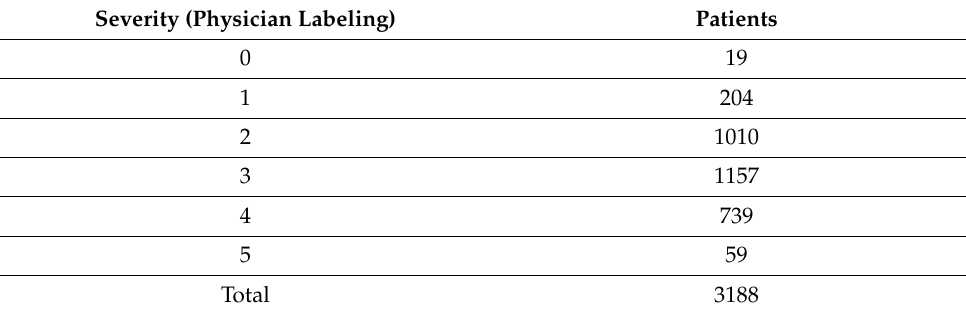
Table 2. Types and quantities of imported data.